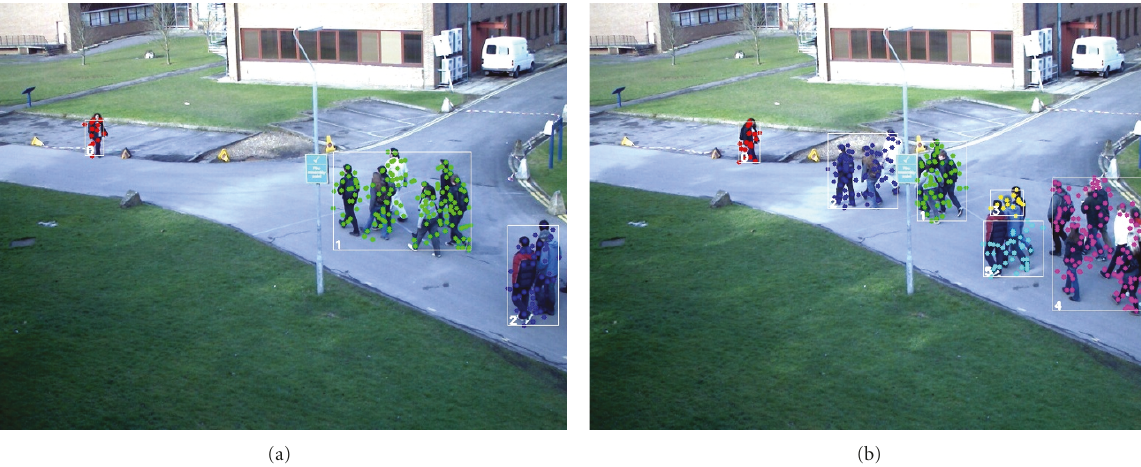
Figure 3: Clusters of point detected by the second stage of the system. Each cluster is enclosed by a bounding box. The images also contain examples of clustering errors. (a) In cluster 1 (green interest points) two groups of people have been erroneously aggregated. (b) A group of people is erroneously split in two clusters, (yellow and cyan points, clusters 3 and 5).